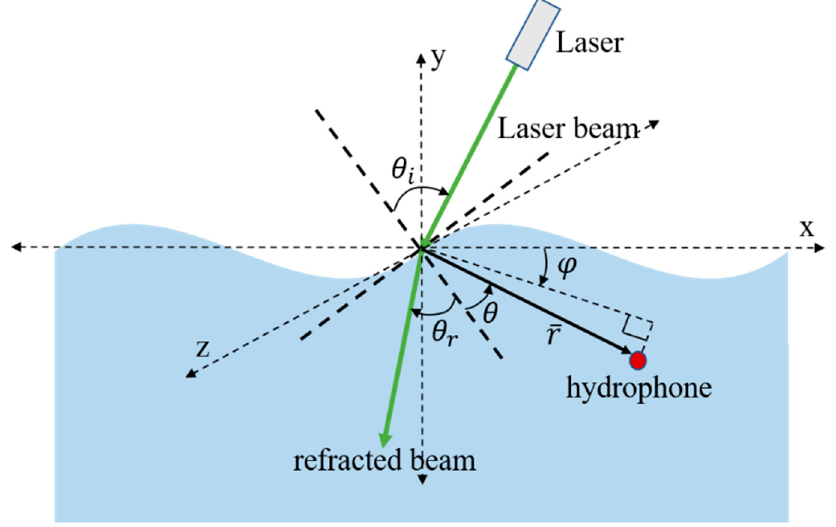
Figure 8. General geometry for linear optoacoustic communication from air to underwater for a wavy water surface.